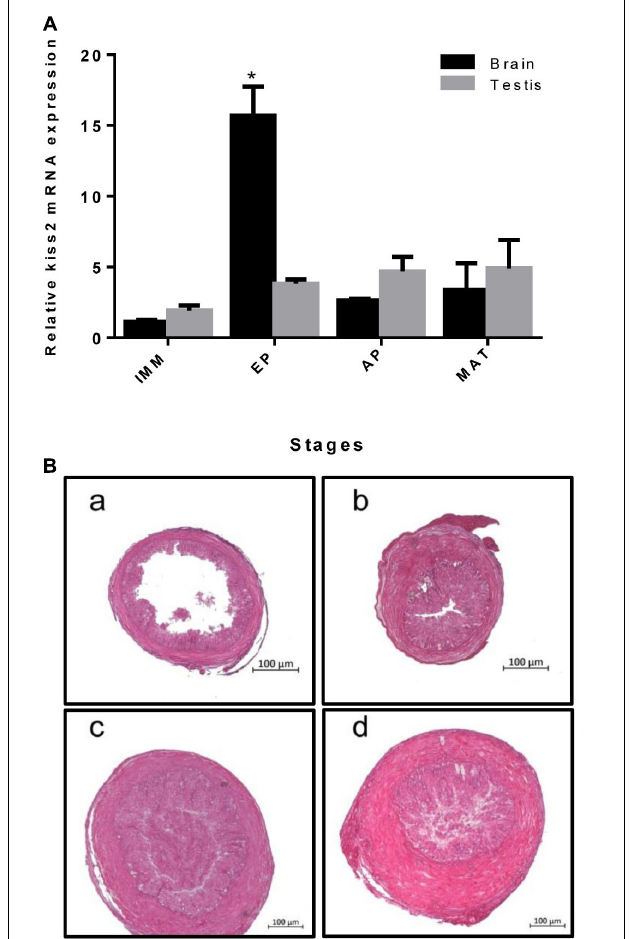
FIGURE 6 | (A) The expression profiles of kiss2 in the brain and testis of male lined seahorses ( n = 8) during different gonad developmental stages. (B) (a–d) Histology of gonads at different gonadal developmental stages in male lined seahorses. (a) Immature (IMM) (3 months old); (b) Early puberty (EP) (4 months old); (c) Advanced puberty (AP) (5 months old); (d) Mature (MAT) (6 months old). The mRNA expression levels were identified by real-time